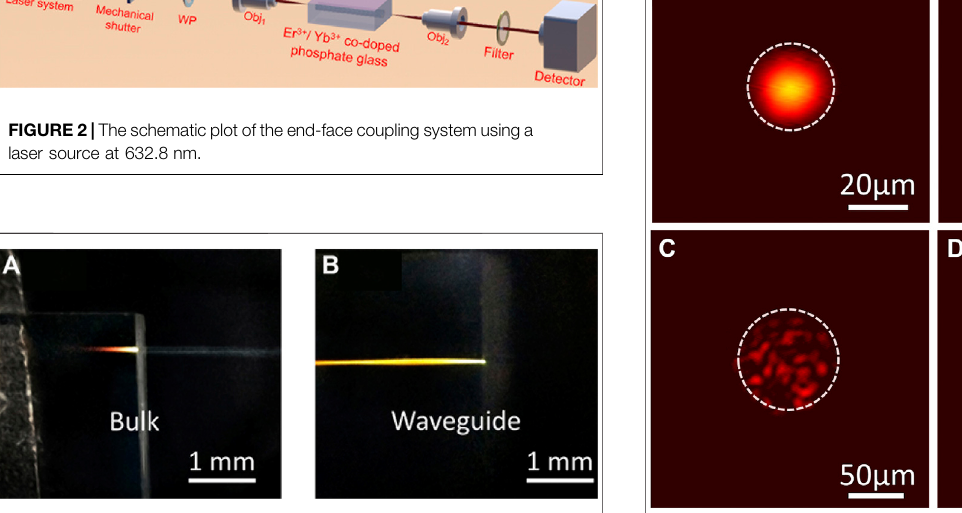
FIGURE 4 | The spatial modal pro fi les of the (A) TE and (B) TM modes for the phosphate glass cladding waveguide of 30 µm diameter at a wavelength of 632.8 nm; The spatial modal pro fi les of the (C) TE and (D) TM modes for the waveguide of 100 µm diameter at 632.8 nm. The dashed lines indicate the spatial locations of laser-induced